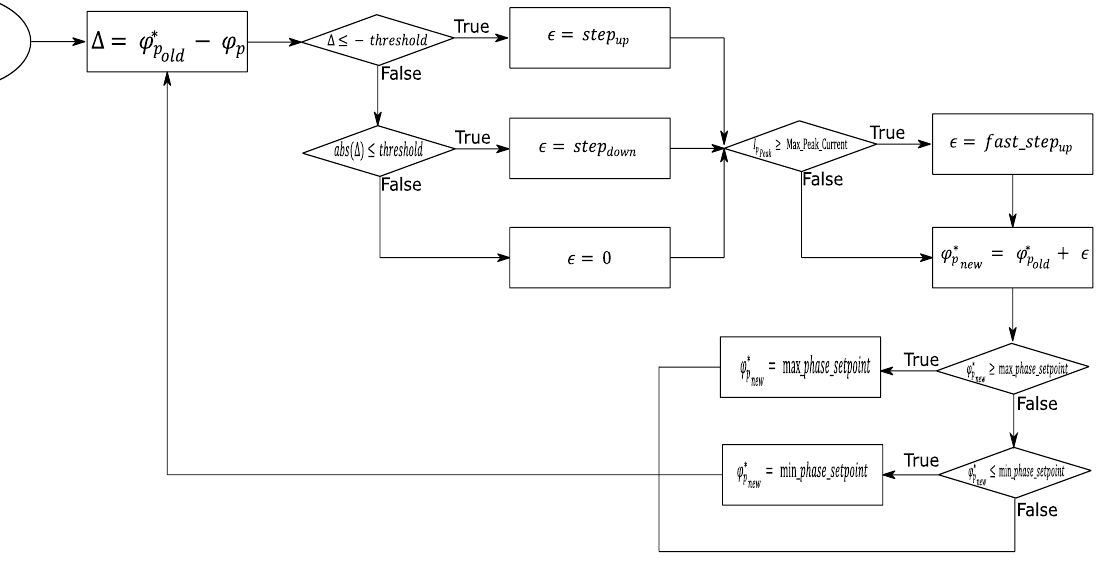
Figure 7. Dynamic set point implementation of 𝜑 𝑝∗ algorithm.